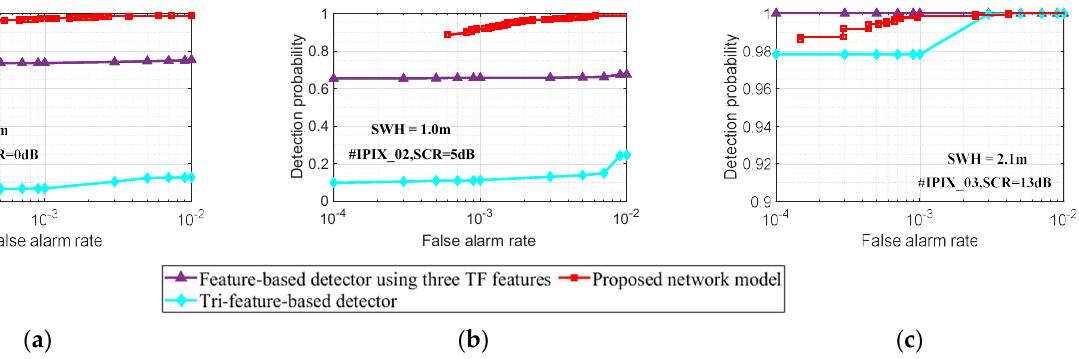
Figure 9. Comparison of different detection methods in different sea states. The detection results are obtained from the test samples and the radar observation time is 0.512 s. ( a ) Lower SCR sea state; ( b ) Medium SCR sea state; ( c ) Higher SCR sea state.